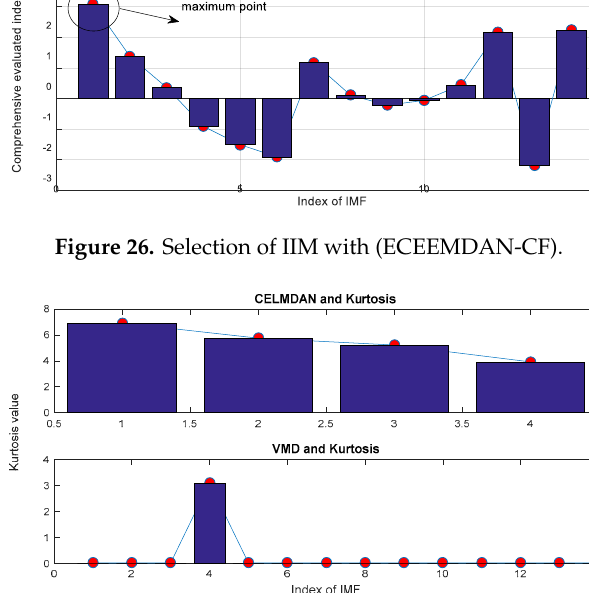
Figure 28. Comparison of fault extraction using the different methods. 4.2. Data from Real Measurement In this section, the fault signal is acquired on the following test rigs (Figure 29). The defective bearing with an inner raceway fault and a healthy bearing were installed on the experiment rig. The temperatures of the inner and outer raceways were monitored by two wireless temperature sensors and two thermocouple sensors, respectively. Accelerometer sensors were installed on bearing house in the vertical direction.